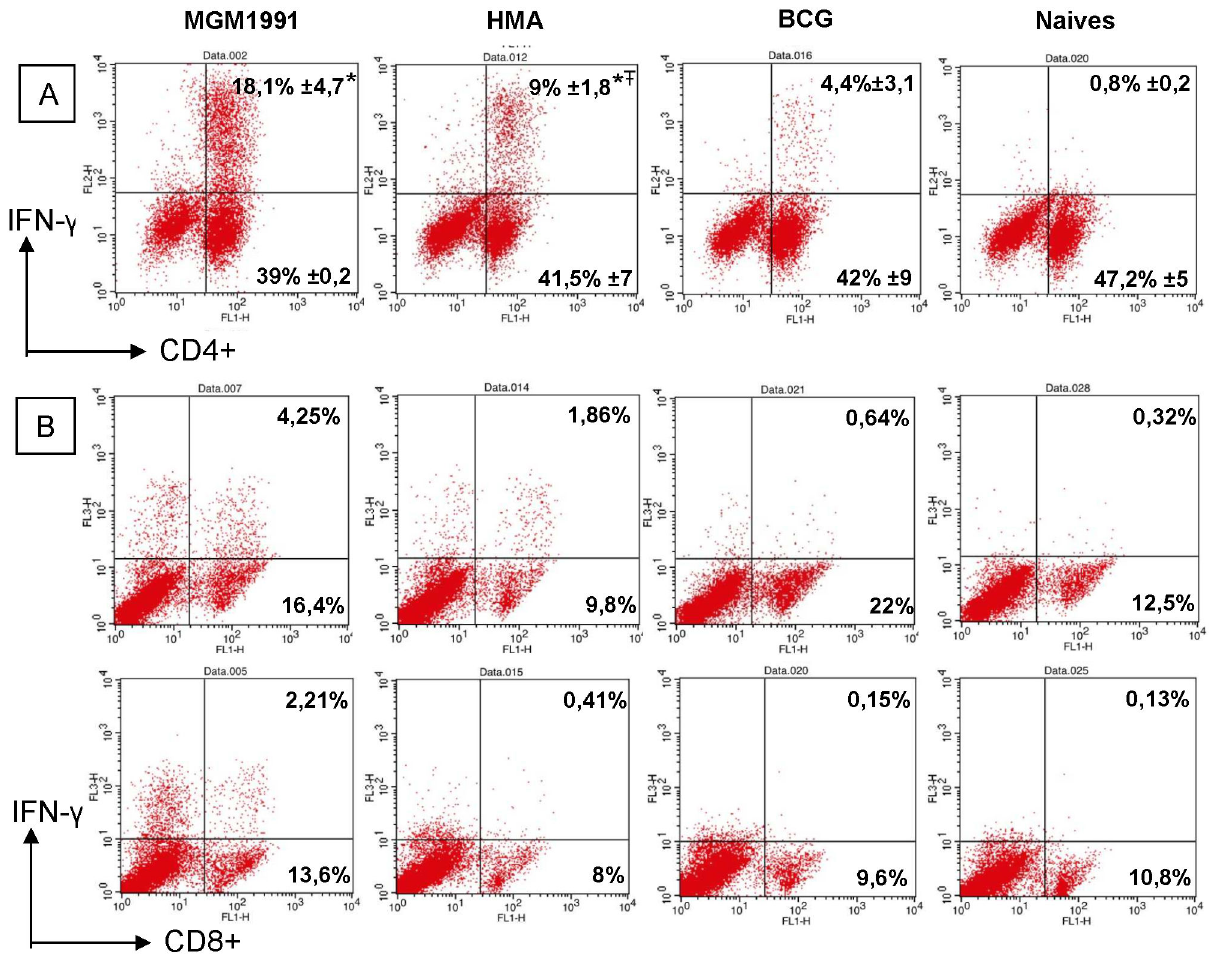
Figure 4. Mycobacteria specific intracellular IFN-γ production in CD4 + and CD8 + T spleen cells of mice vaccinated with MGM1991, HMA or BCG vaccine at 4 weeks after immunization. Upper panel (A): ICS staining of CD4 + spleen cells from C57BL/6 mice vaccinated 4 weeks before with 5x10 4 CFU of MGM1991, HMA or M. bovis BCG by the subcutaneous route or from unvaccinated (naïve) mice. Mean % of positive cells in each quadrant (of 3 mice tested individually in each group). Lower 2 panels (B): ICS staining of CD8 + spleen cells from C57BL/6 mice vaccinated 4 weeks before with 5x10 4 CFU of